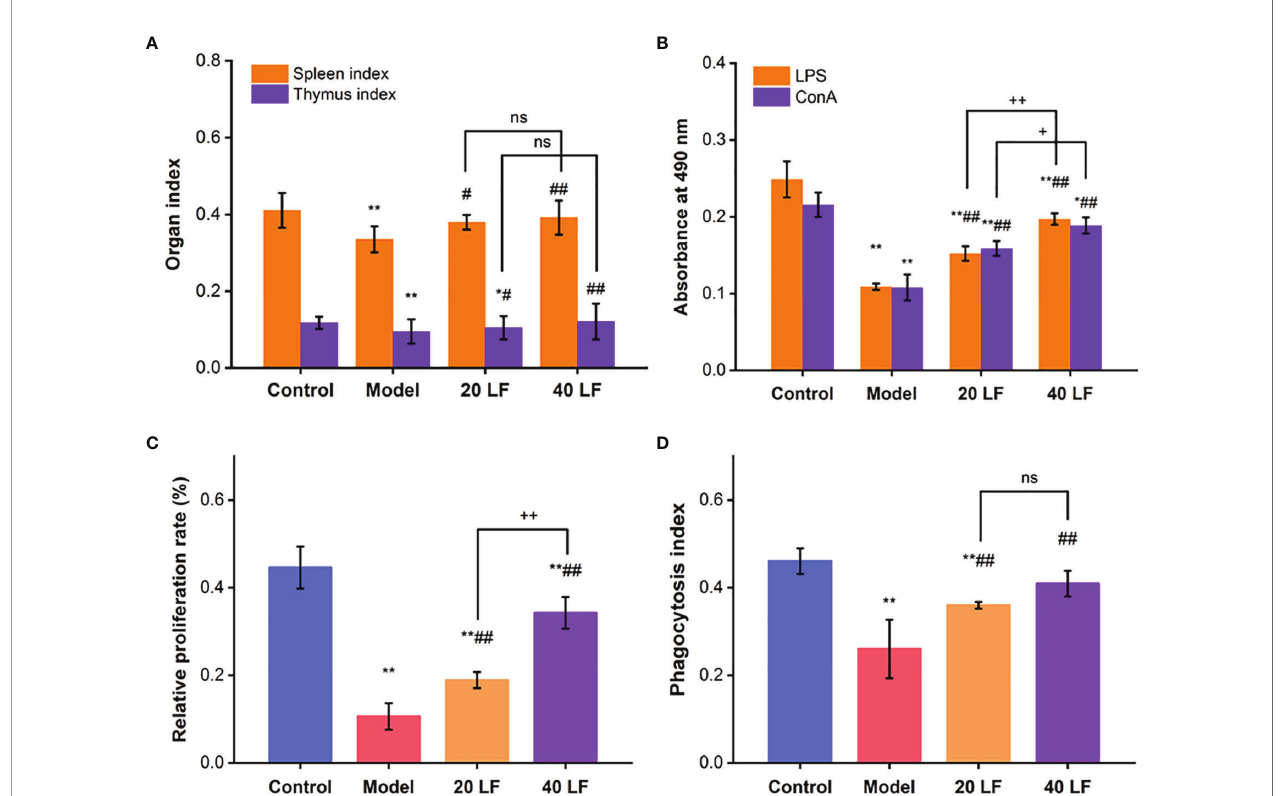
FIGURE 1 | Immune organ indexes of spleen and thymus (A) , splenic lymphocytes proliferation (B) , peritoneal macrophage proliferation (C) , and the phagocytic (D) index, ( n = 8). * P < 0.05, ** P < 0.01 vs control; # P < 0.05, ## P < 0.01 vs model, + P < 0.05, ++ P < 0.01 compared between 20 LF and 40 LF, and ns means no signi fi cant